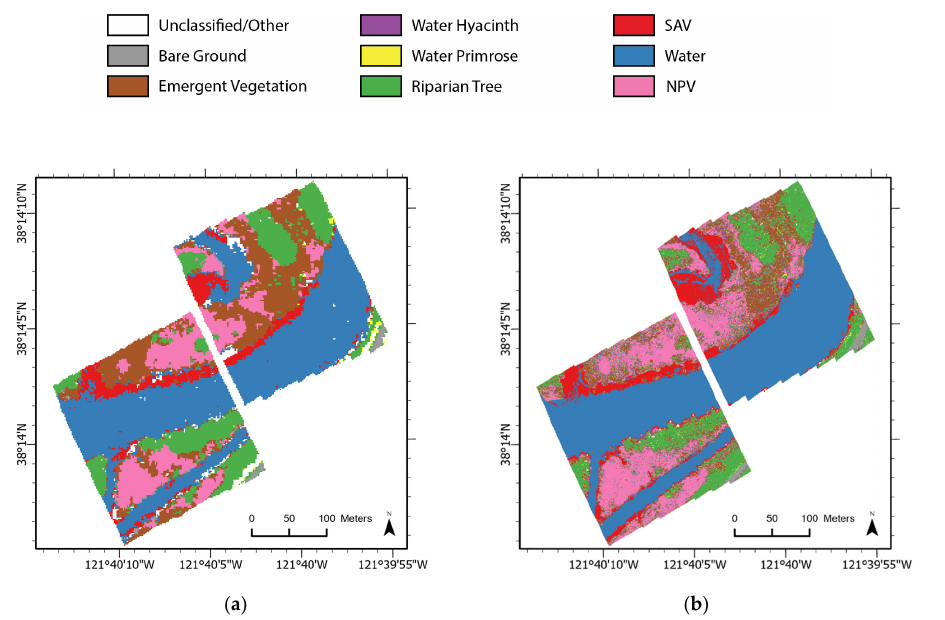
Figure 7. Classification maps of the study area. ( a ) HyMap map; ( b ) Nano map. Table 4. Class area coverage for the HyMap, Nano, nearest neighbor (NN) resampled Nano, and moving window resampled Nano